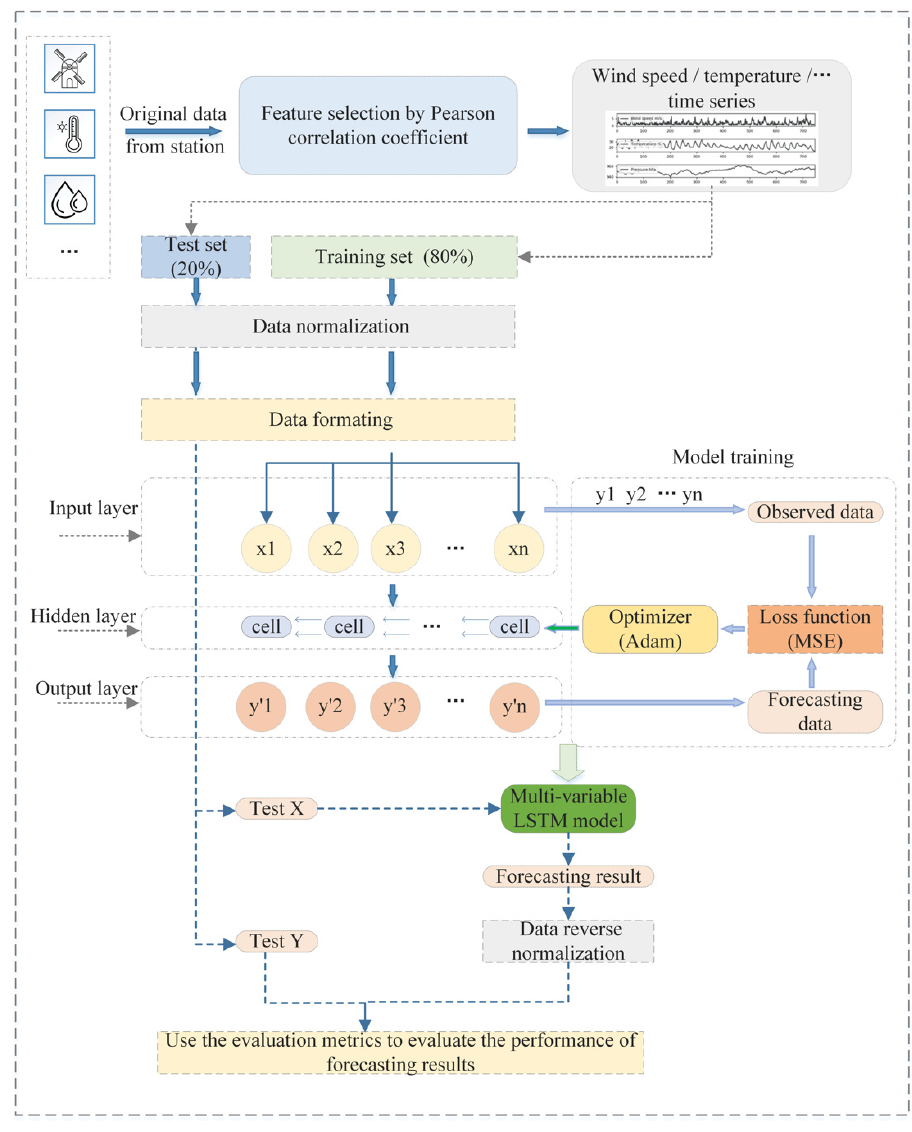
Figure 5. Figure 5. The framework of the proposed multi-variable LSTM network method for wind speed forecasting.